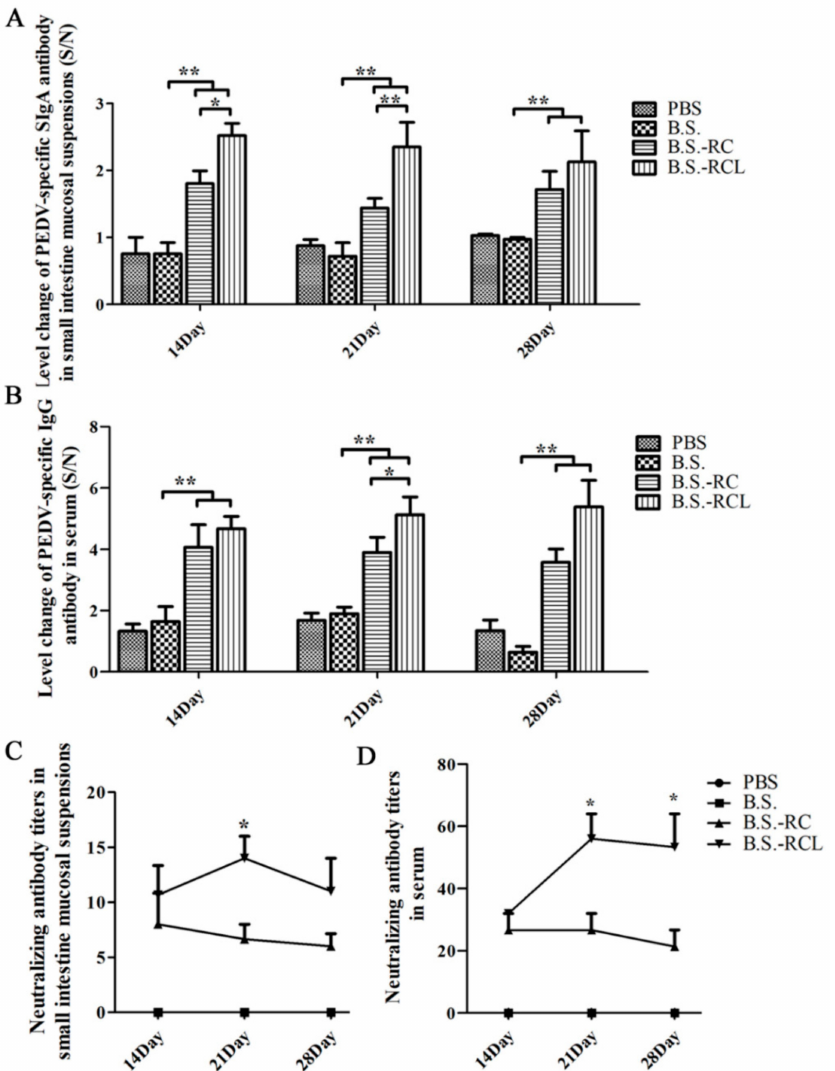
Figure 5. The detection of specific antibody levels after oral immunisation. After 14, 21 and 28 days of immunisation, the samples were collected to analyse PEDV-specific SIgA ( A ), IgG ( B ) and neutralising antibodies in small intestine mucosal and serum ( C , D ) (the value of S/N was calculated) by indirect ELISA ( n = 6). Data are shown as the mean ± SD of three samples. *, p < 0.05; **, p <